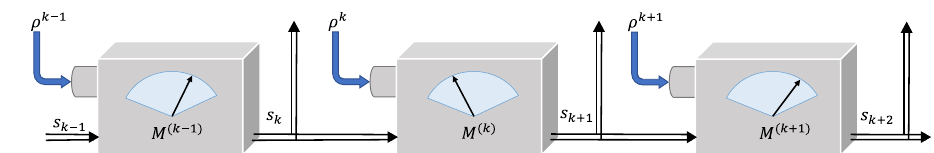
Fig. 1 Quantum preparation game from the referee ’ s perspective. In each round k of a preparation game, the referee (measurement box) receives a quantum state ρ k from the player. The referee ’ s measurement M ( k ) will depend on the current game con fi guration s k , which is determined by the measurement outcome of the previous round. In the same way, the outcome s k + 1 of round k will determine the POVMs to be used in round k + 1. Recall that the player can tailor the states ρ k to the measurements to be performed in round k , since they have access to the (public) game con fi guration s k , shown with the upward arrow leaving the measurement apparatus.